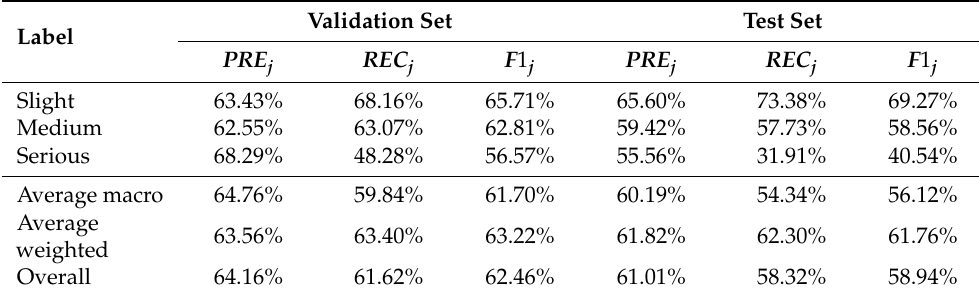
Table 6. Performance of the HSAN for the three severity labels.